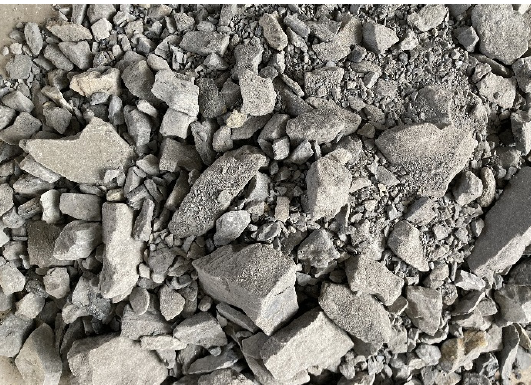
Figure 3. Crushed gangue sample for confined compaction test.